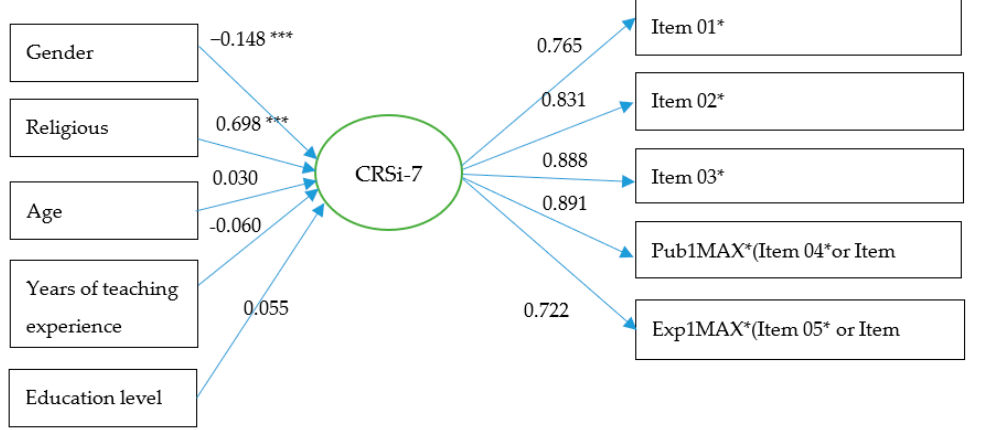
Figure A3. MIMIC model for CRS-15; * Items 01–15 refer to the Item 01–15 in Appendix D. Appendix B. Attachment: Chinese Version of the Centrality of Religiosity Scale (CRSi-20) 請跟據個人對於「神」或「神靈」的觀感來回應以下題目 。